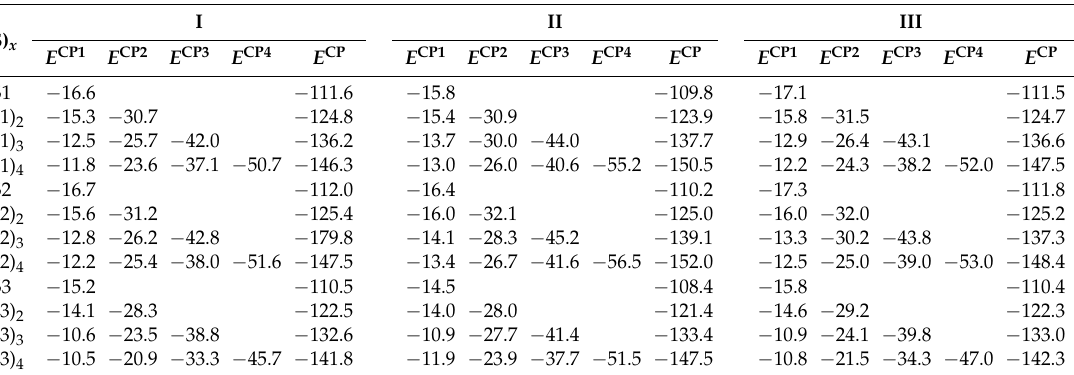
Table 3. Interaction energies (kcal/mol) of X ··· ( S ) x .